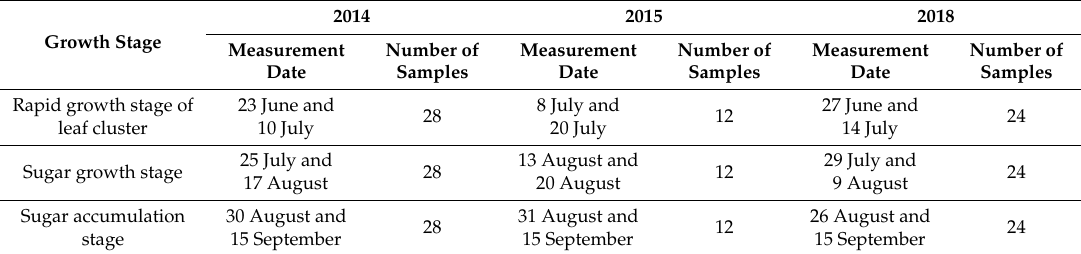
Table 2. Dates of data collection during the three-year